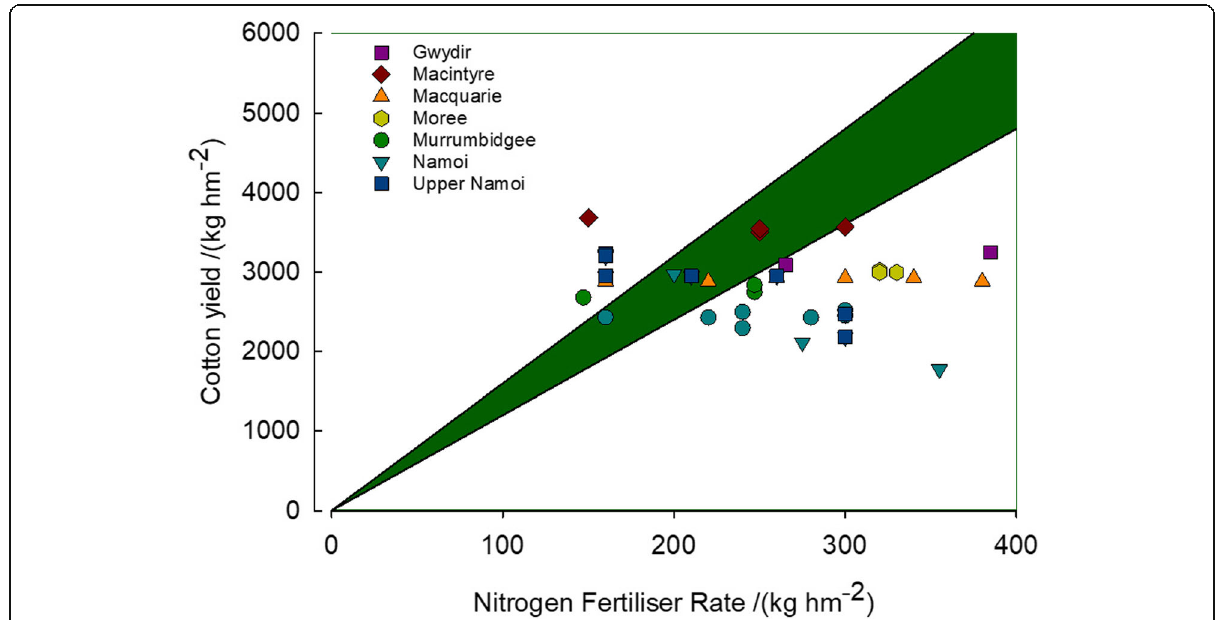
Fig. 5 NFUE in the Action on the Ground (Schwenke 2017) and CottonInfo trials (Anon 2013) in irrigated cotton